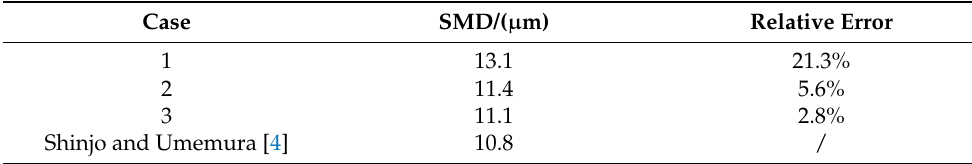
Table 3. Comparison of SMD in different